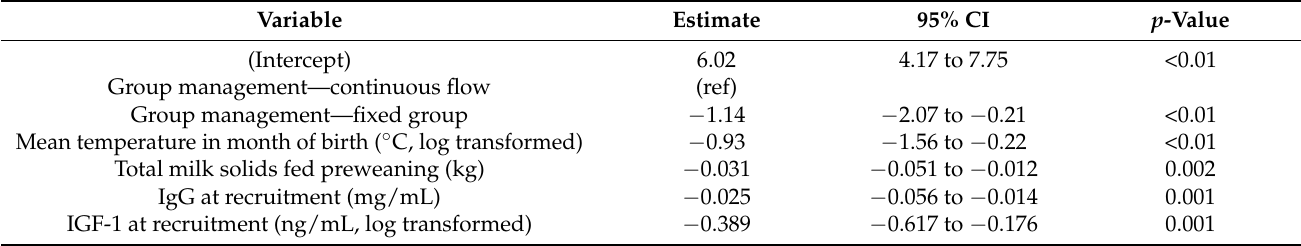
Table 4. Results of the linear mixed effects model for variables associated with the risk of dairy heifers ( n = 492 on 11 farms) showing clinical signs of bovine respiratory disease (BRD) in their first nine weeks of life.